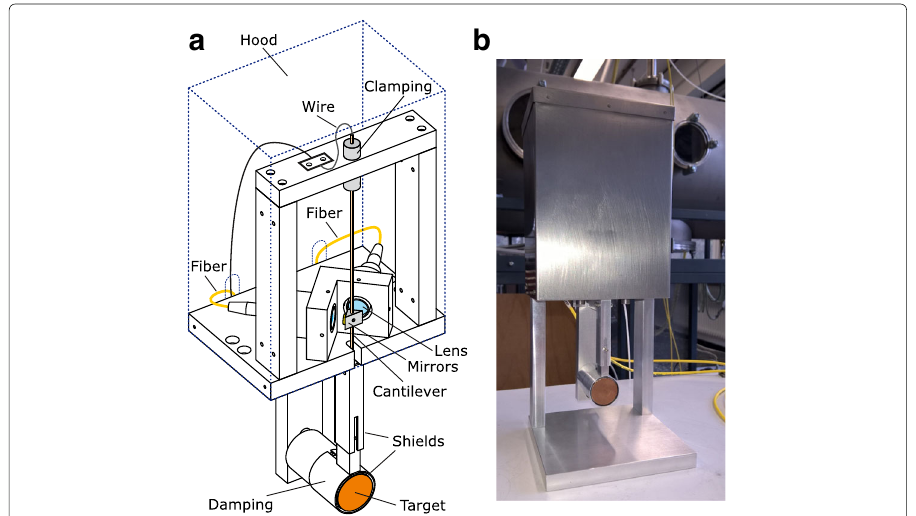
Fig. 1 Implementation of the force probe. a Drawing with the inner parts of the probe, b photograph of the probe before mounting in the vacuum chamber (in the background). Note the circular copper target and the two yellow fiber optic